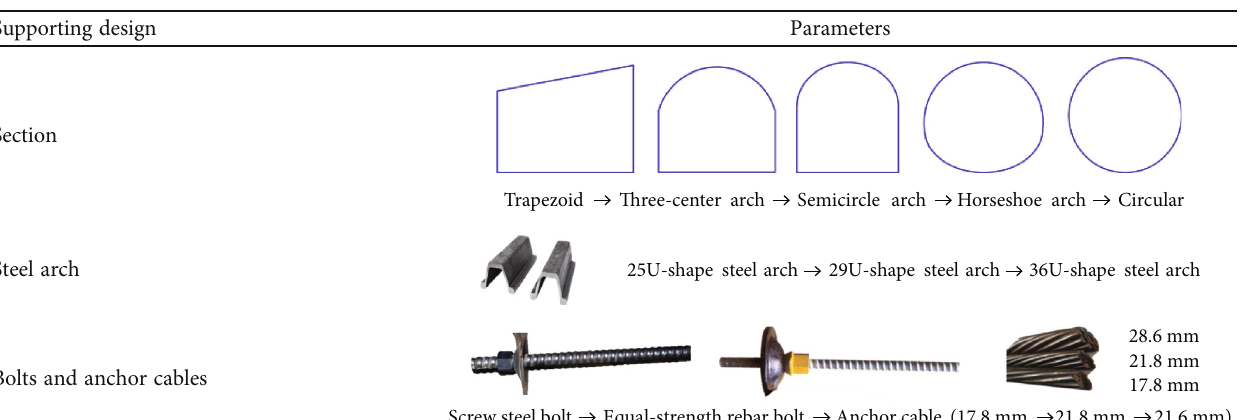
Table 1: Development of the support system in the Xiaokang coal mine.